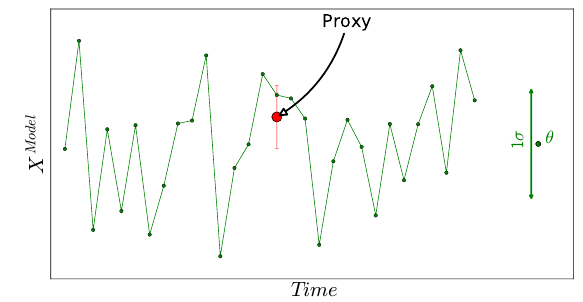
Figure 14. Schematic showing how the expected value (the mean) and the deviation from the mean for the time slice simulation are selected. The model simulation is 25 years long. The green line rep- resents the model state.